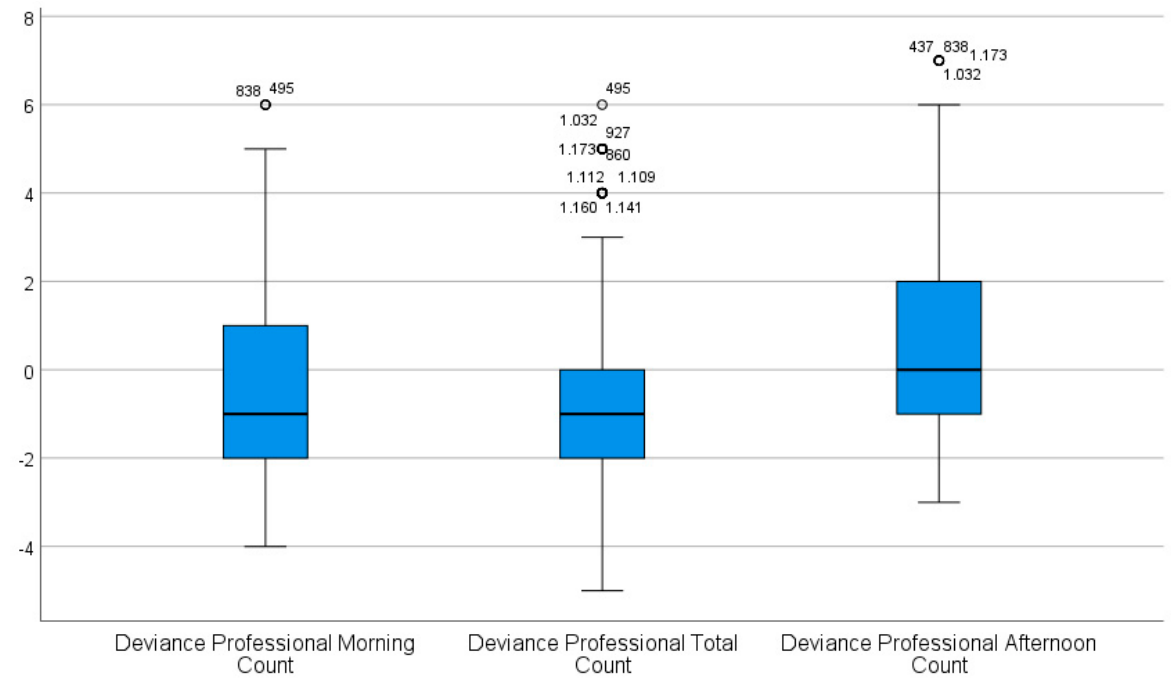
Figure 3. Boxplot of the deviance of the species richness estimates of the people from the professional